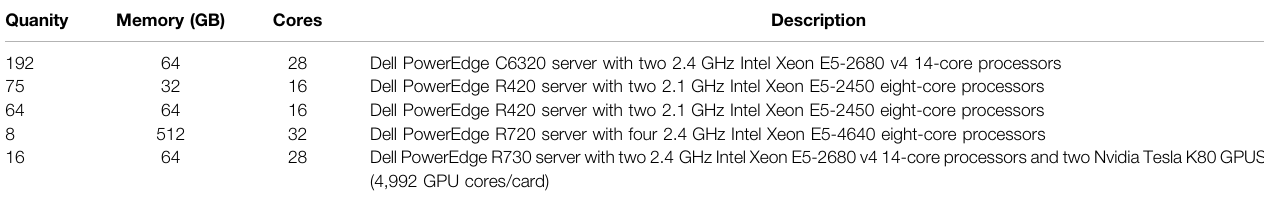
TABLE 1 | Talon3 computer nodes.